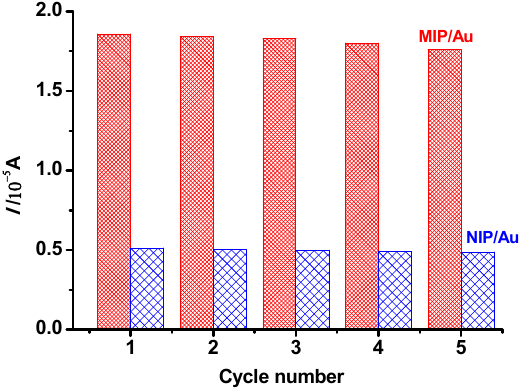
Figure 10. The regeneration of the MIP/Au and NIP/Au in 0.5 mol·L − 1 H 2 SO 4 by shaking for 3 h.